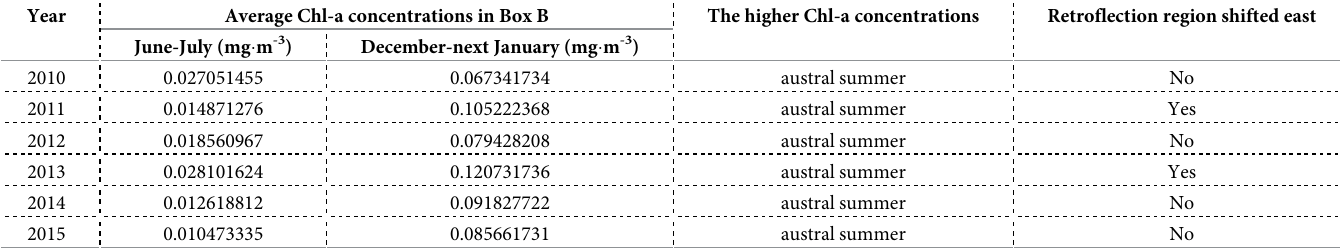
Table 1. Observation of Chl-a concentration and shifting eastward retroflection from 2010 to 2015. Average Chl-a concentrations in Box B The higher Chl-a